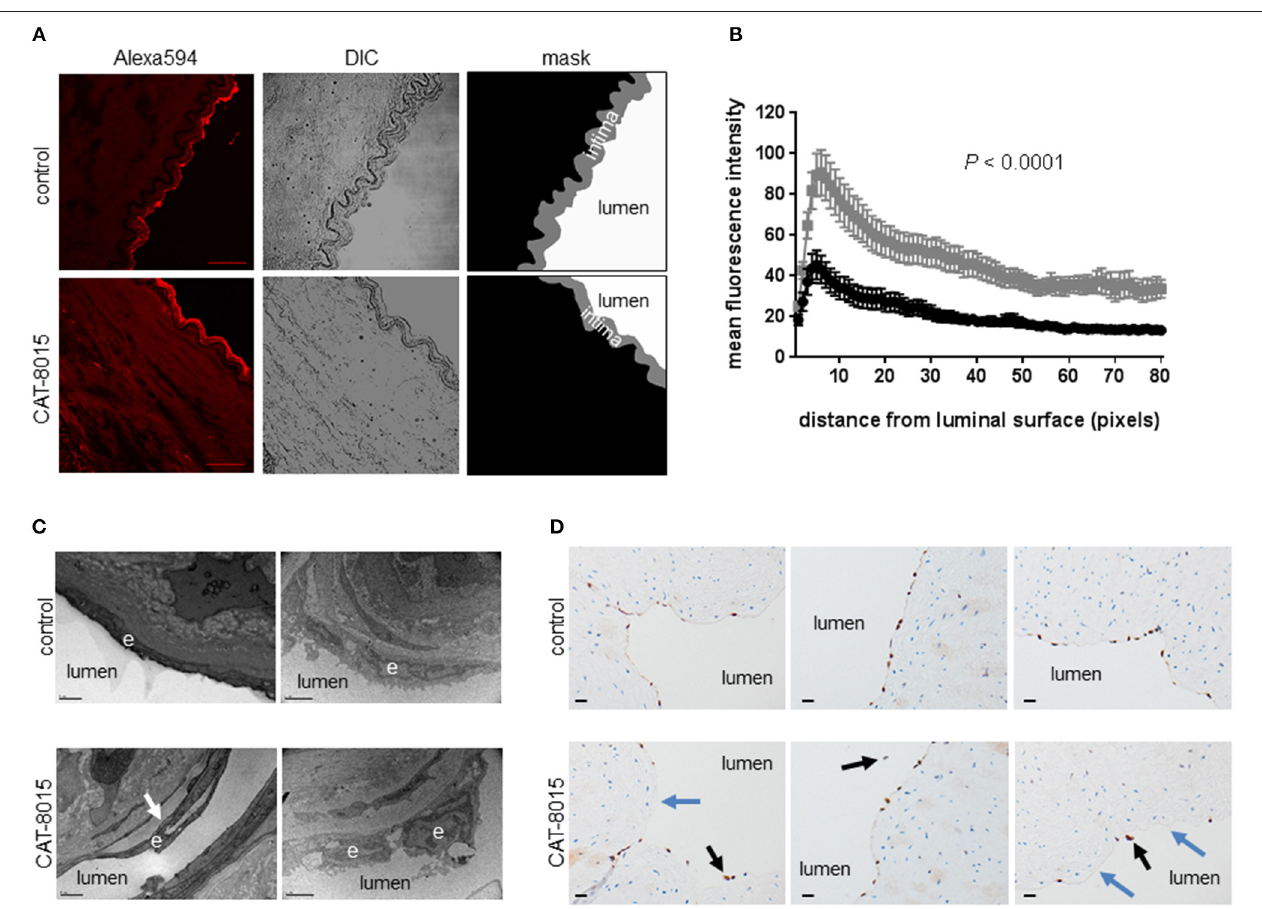
FIGURE 6 | The effect of CAT-8015 on ECs of excised human mesenteric arteries. (A) Representative confocal microscope images of transverse cryosections (10 µ m) of excised human mesenteric arteries ( n = 3) incubated with buffer only (top) or buffer containing CAT-8015 (bottom) for 1 hour at 37 ◦ C in the presence of the vascular permeability marker Alexa594-BSA. Bars represent 40, µ m. To quantify the effect of CAT-8015 on vascular permeability, Alexa594 images (left) were converted to mask images (right) and the mean intensity of red fluorescence across the intima (in grey) was plotted against the distance from the luminal surface (expressed in pixels, 1 pixel = 0.5 µ m). (B) Average ( ± SEM) profiles of red fluorescence from excised human mesentery arteries ( n = 3) treated with buffer only (in black) or buffer containing CAT-8015 (in gray). Image analysis was performed for 10–15 different images per sample. Statistical significance was determined using unpaired, two-tailed t -test with Welch’s correction. (C) Representative transmission electron microscopy images of cross-sections of excised human mesenteric arteries ( n = 2) incubated for 1h at 37 ◦ C with buffer only (control) or buffer containing CAT-8015. Arrows indicate detachment of ECs (e) from the basal membrane. Bars represent 1 µ m (left), and 2 µ m (right). (D) Representative ERG immunohistochemistry images of cross-sections of excised human mesenteric arteries ( n = 3) incubated for 1h at 37 ◦ C with buffer only (control) or buffer containing CAT-8015. Black arrows indicate detached ECs from the basal membrane while blue arrows